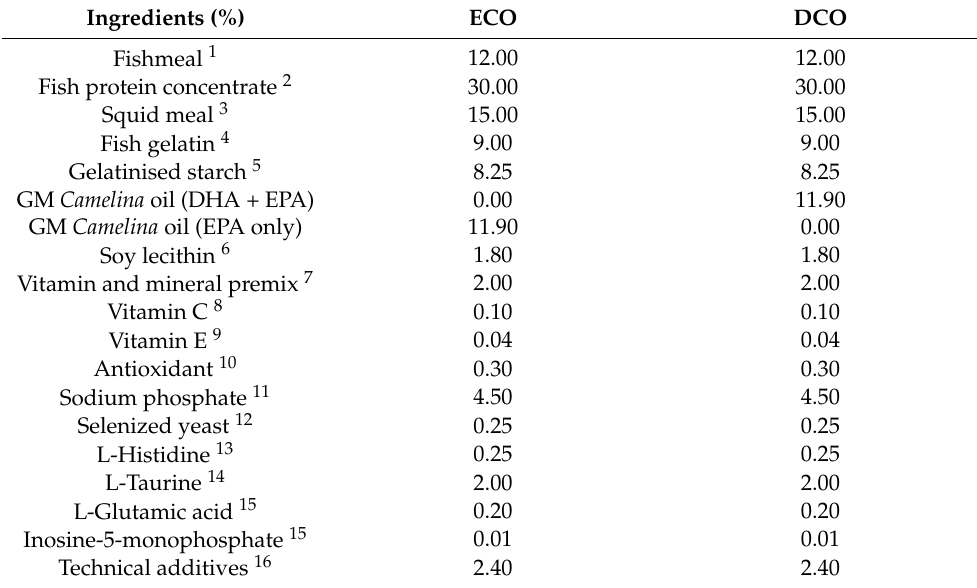
Table 1. Formulations of the experimental diets, ECO and DCO, including detailed list of the ingredients